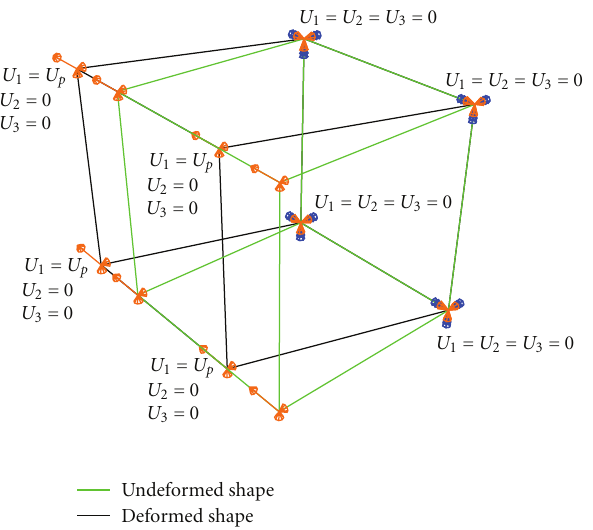
Figure 8: Boundary conditions for in-plane shear loading.